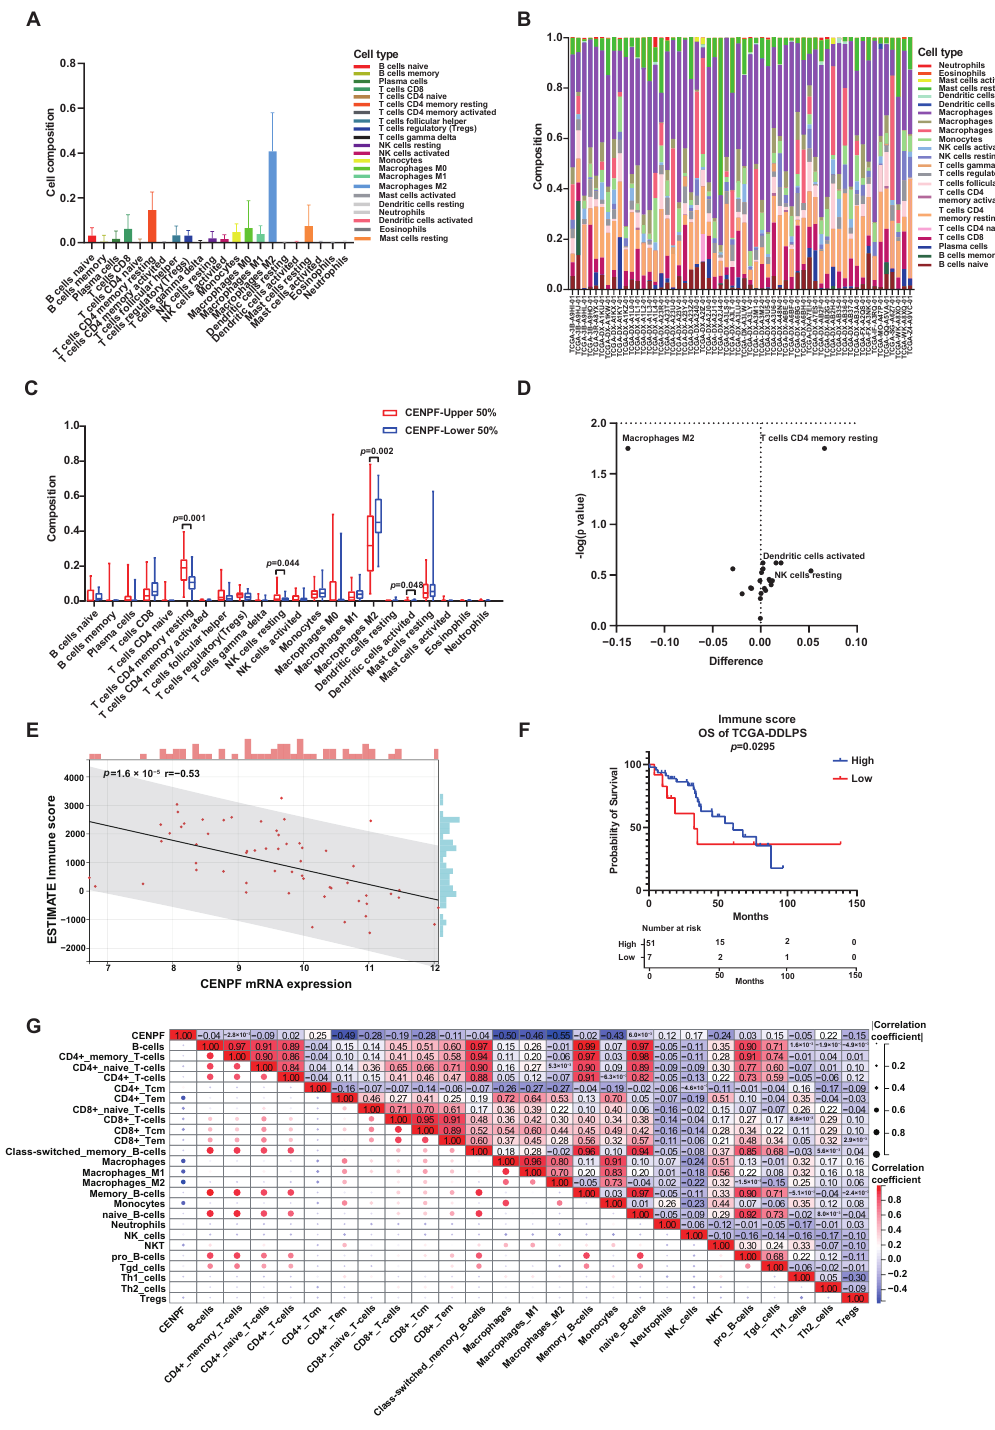
Figure 7. CENPF-related immune infiltration analysis of LPS tumor microenvironment (TME). Com- position analysis of immune cells infiltrated in LPS tissues: ( A , B ) the proportion of various